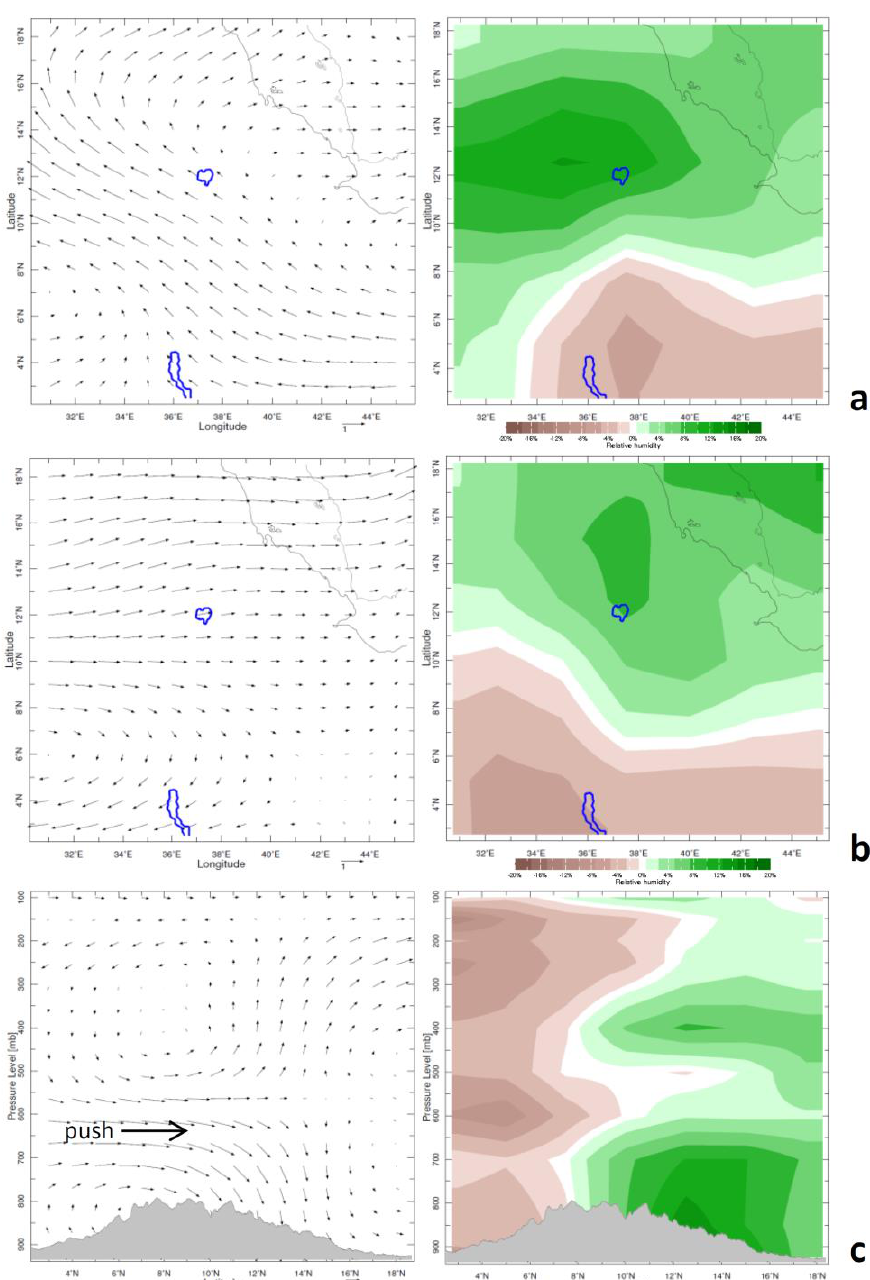
Figure 3. Composite differences of 5-most minus 5-least seasons 925 – 700 hPa circulation (left) and humidity: ( a ) ‘Early’ (Apr.–May), ( b ) ‘Late’ (Oct.–Nov.). ( c ) Meridional circulation and humidity in N-S vertical section with topography for 5-most minus 5-least ‘Narrow’ (Jul.–Aug.) seasons.